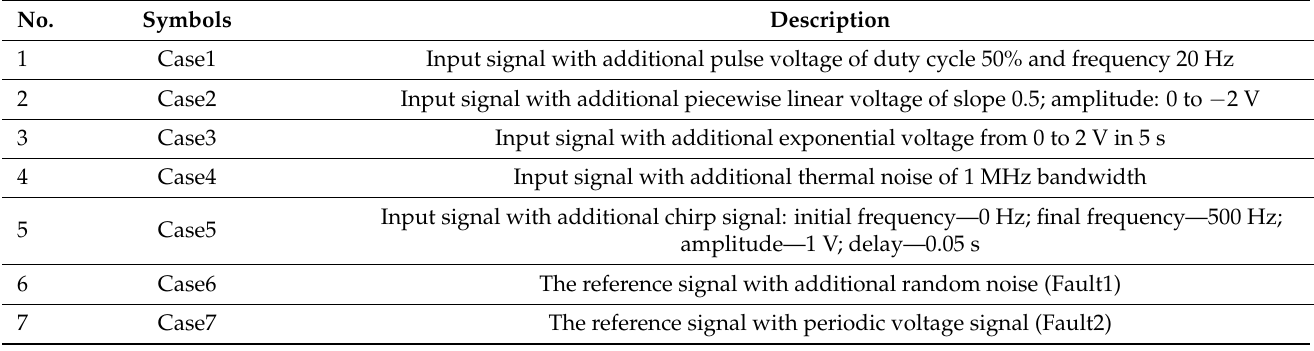
Table 1. The cases of 7 groups of signals.